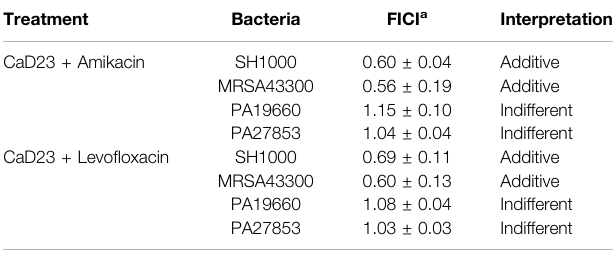
TABLE 2 | Evaluation of the interactive antimicrobial effect of CaD23 and antibiotics, including amikacin and levo fl oxacin, using checkerboard